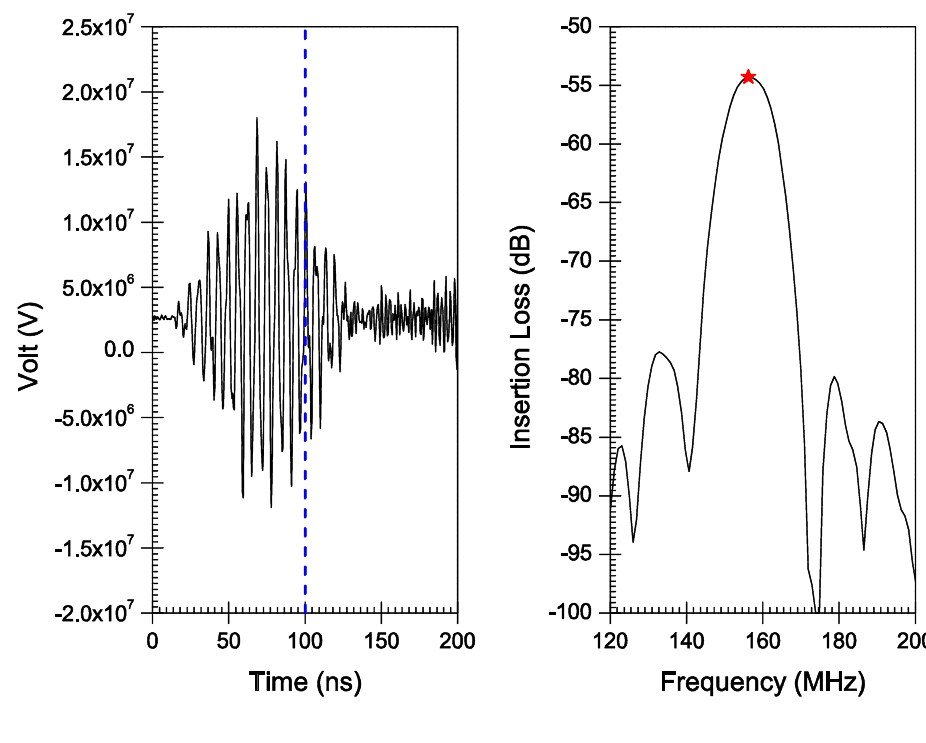
Figure 6. Time and frequency response for h /λ = 0.2.